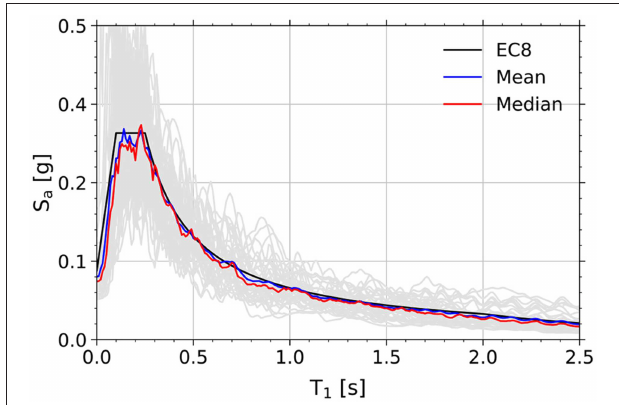
FIGURE 2 | Response spectra of selected ground motion suite and EC8 for Porto.